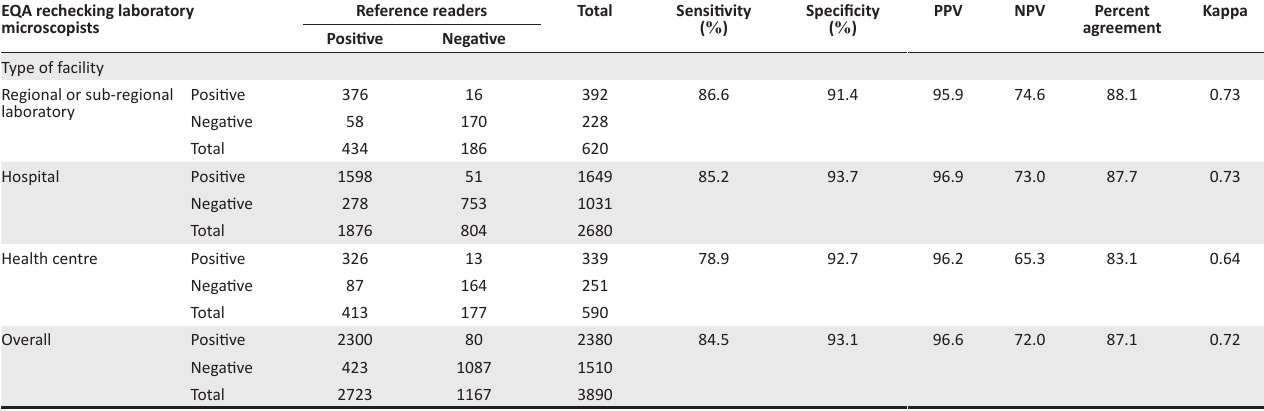
TABLE 4: Overall sensitivity, specificity, predictive values and agreements of participants with reference readers in detecting tuberculosis bacilli, Ethiopia, April–July, 2015. EQA rechecking laboratory microscopists